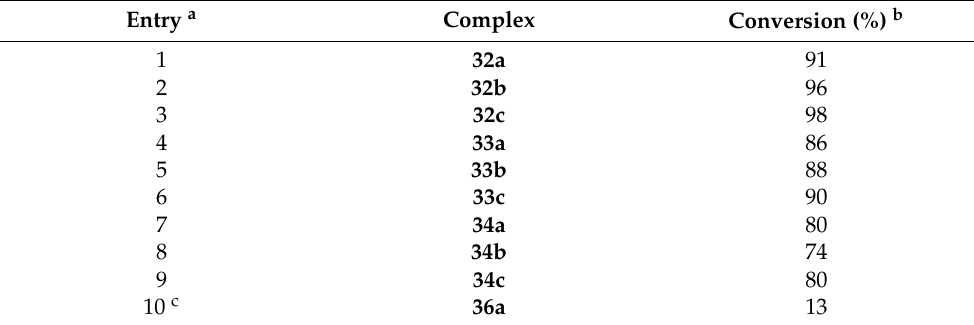
Table 12. Hydroamination reaction.